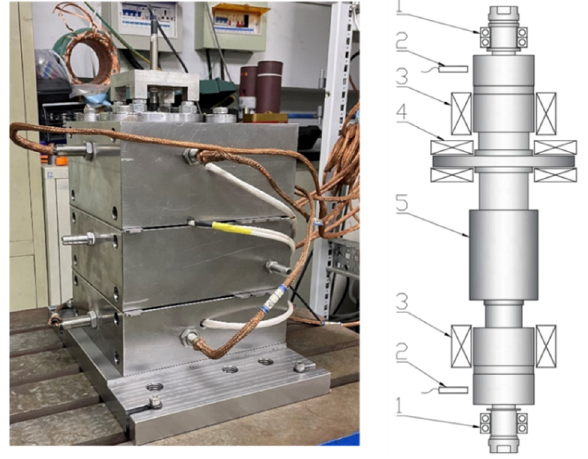
Figure 6. AMB–rotor–TDB drop test bench: 1—TDBs, 2—eddy current sensors, 3—radial AMBs, 4—axial AMB, 5—rotor. Table 1. Parameters of the AMB–rotor–TDB system.